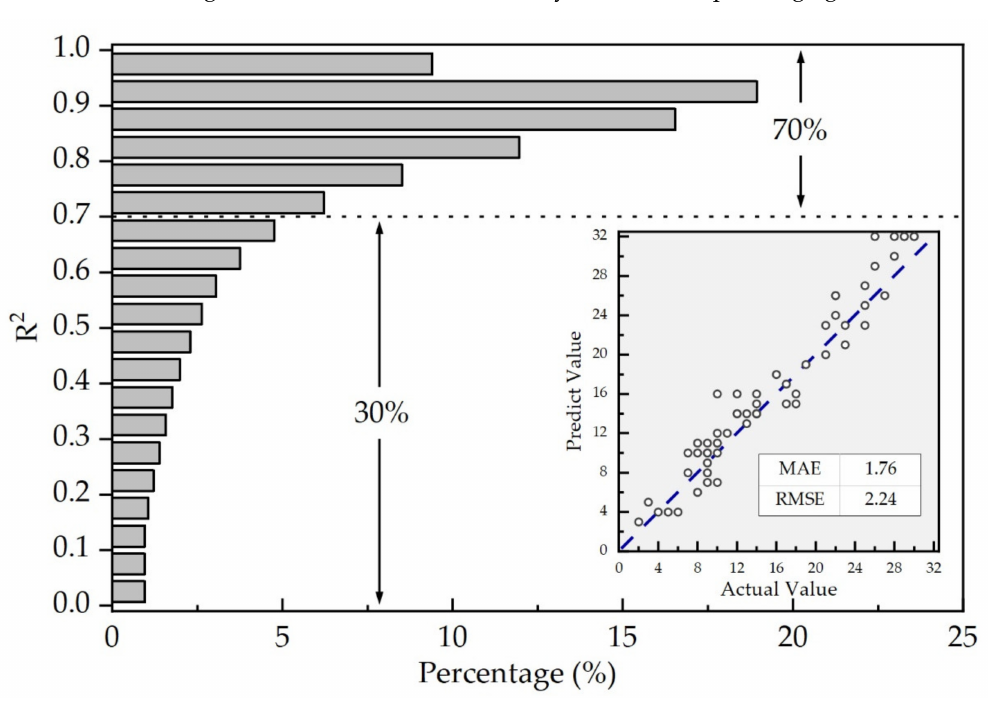
Figure 6. Accuracy validation of orchard planting age estimation. The blue line is the 1:1